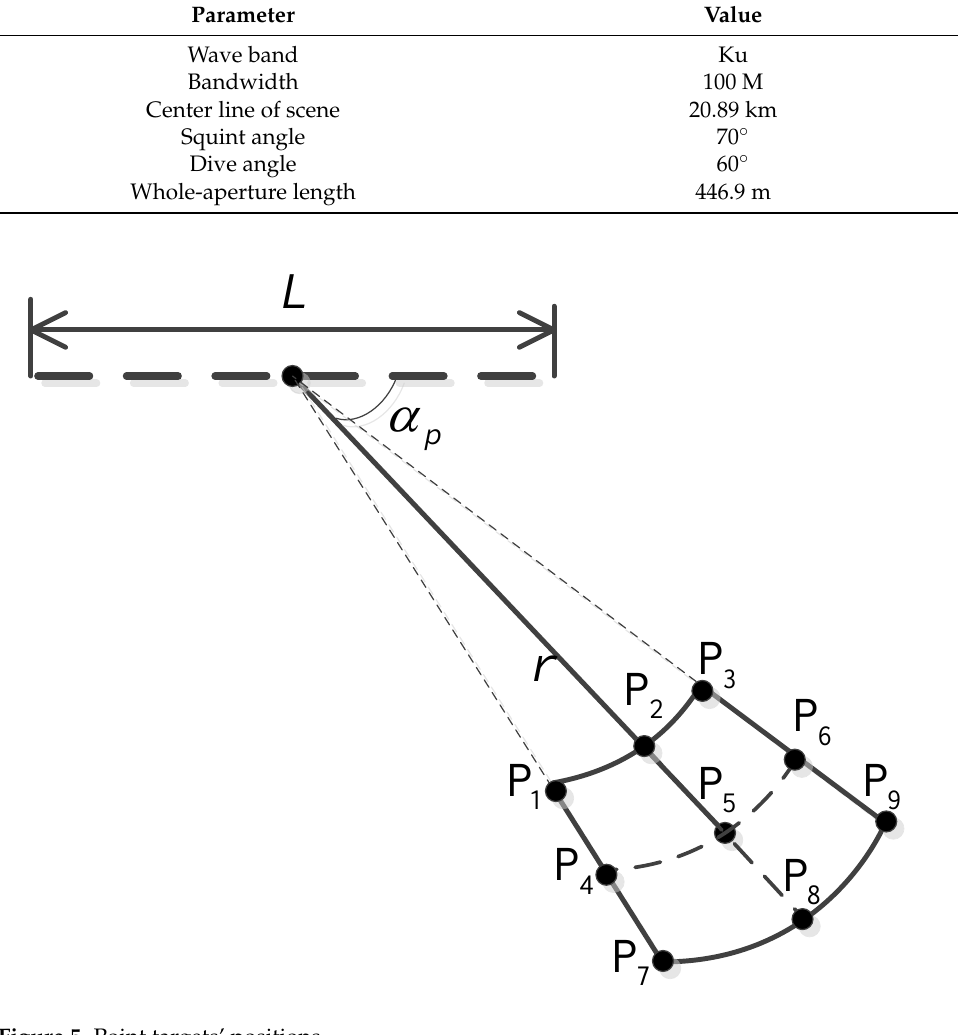
Figure 5. Point targets’ positions. Table 2. Point targets’